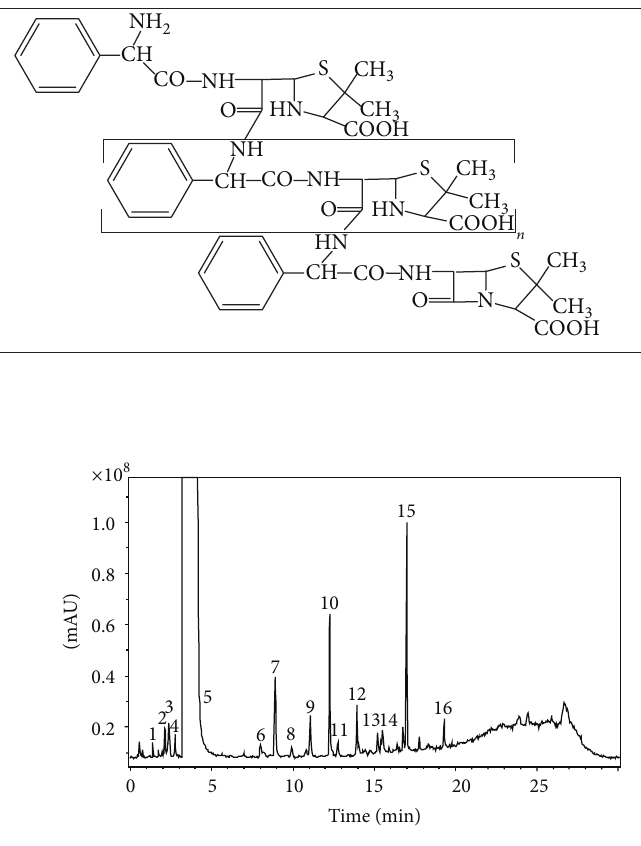
Figure 1: The total ion chromatography of ampicillin capsule (DAVA). The peaks were numbered according to their retention